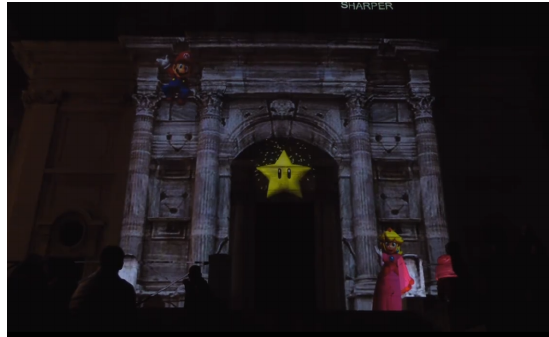
Figure 4. An example of storytelling on the fac¸ade: SuperMario Ancona Sharper 2017